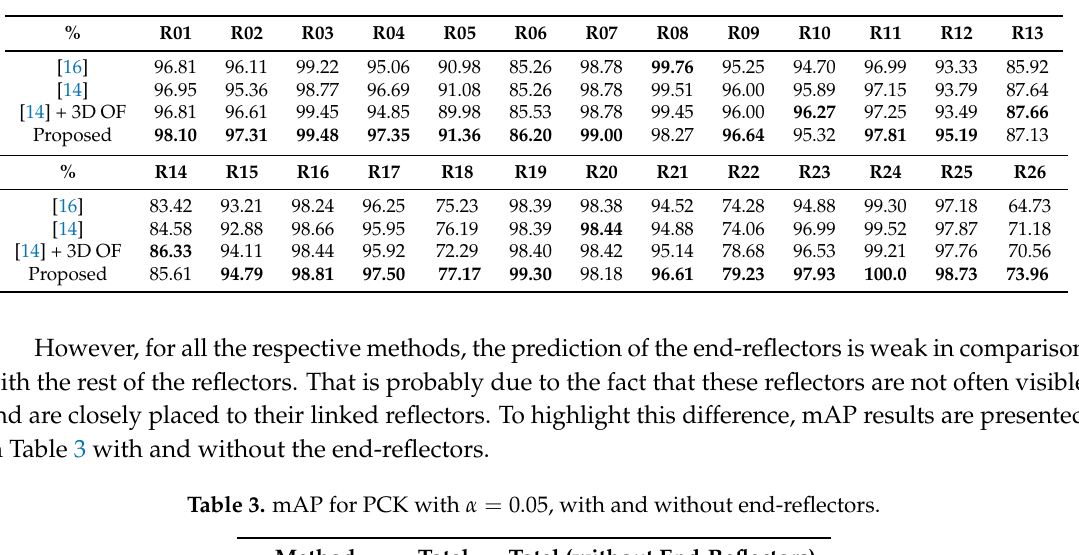
Table 2. AP for PCK with α = 0.05, for each of the 26 reflectors. The proposed FCN method outperforms the rest of the methods for the 80.7% of the reflectors (i.e., 21 out of 26).